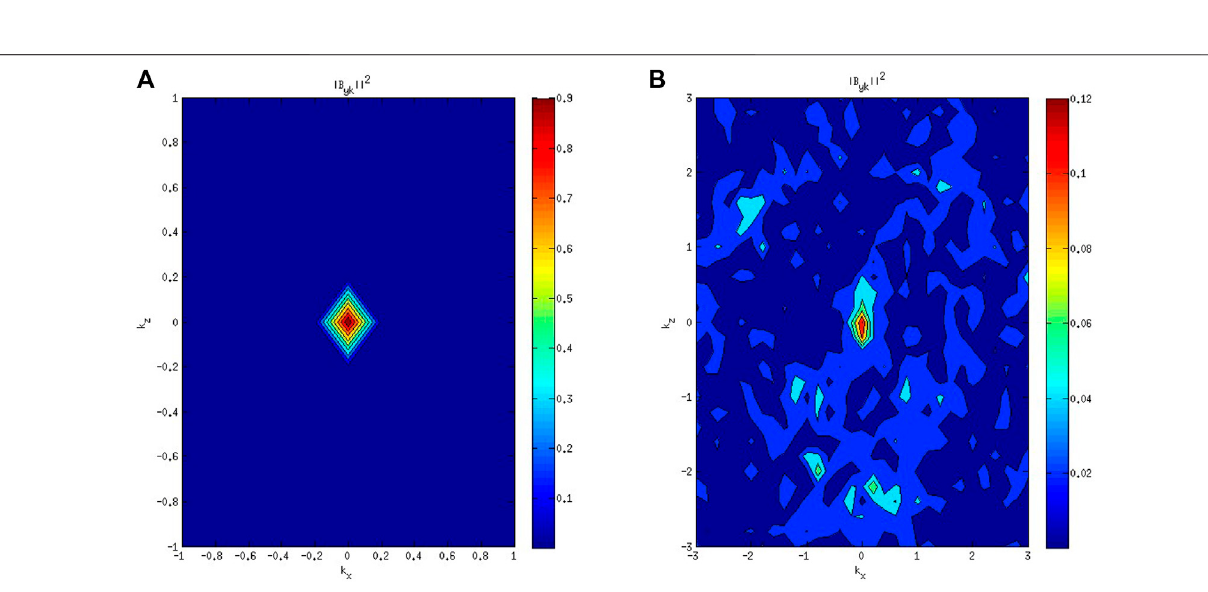
FIGURE 9 | Contours of normalized | B yk | 2 in k x , k z space for pump KAW at (A) t = 20 and (B) t = 32. “ Reproduced from [(Gaur and Sharma, 2015), J. Geophys. Res. Space Physics, 120, 2,397 – 2,408, doi:10.1002/2014JA020771], with the permission of AGU Publishing. ”